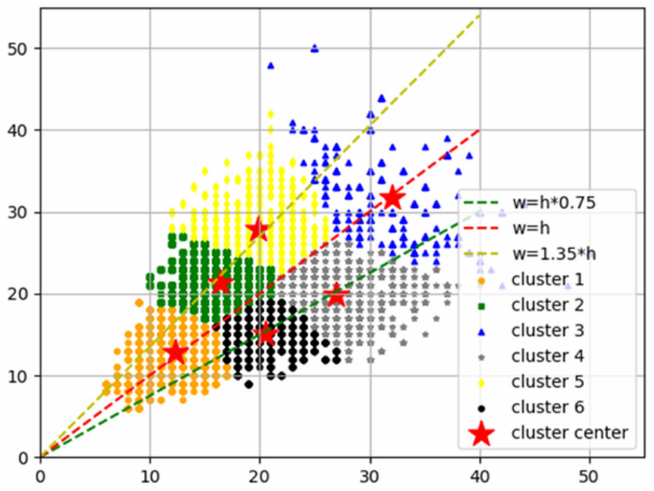
Figure 7. Results of K-means clustering on the size of large